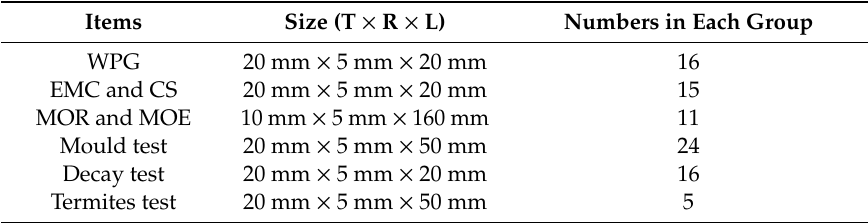
Table 1. The basic information of